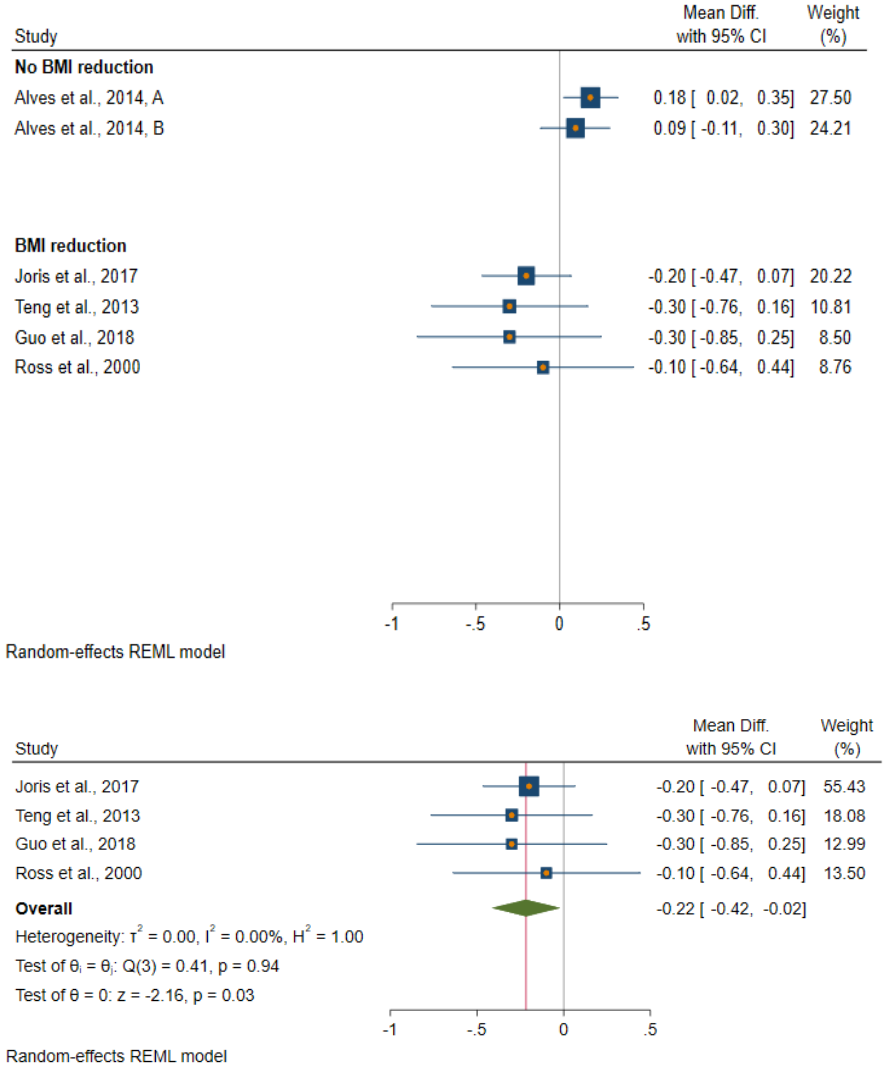
Figure 3. Forest plot of studies which evaluated an effect of a reduction in body fatness on fasting glucose